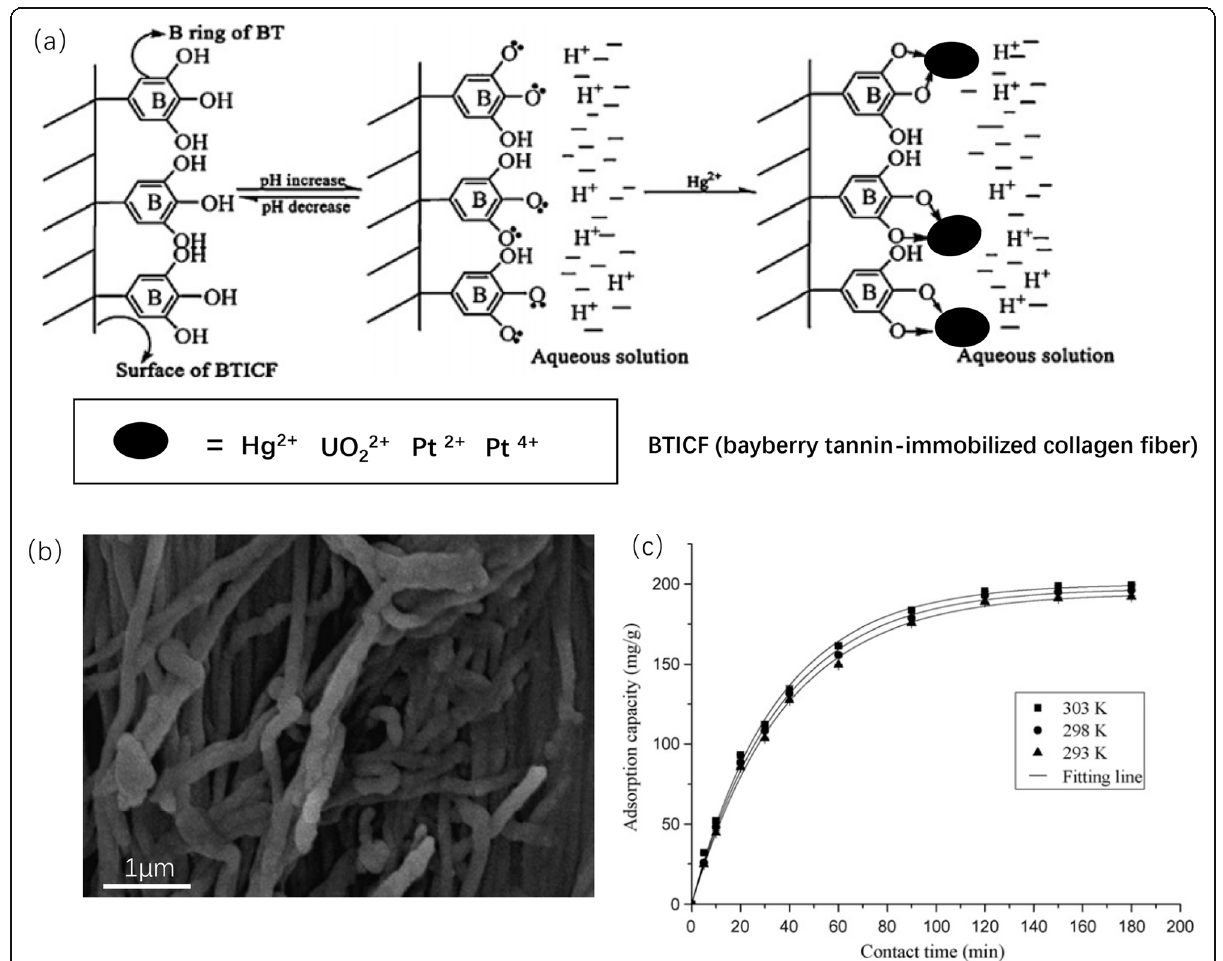
Fig. 3 a Mechanism of bayberry tannin-immobilized collagen fiber (BTICF) to metal ions; b SEM images of BTICF; c absorption capacity of modified skin collagen fiber to Hg2+ ions [43, 50]. Copyright (2009), with permission from Elsevier, and Copyright (2004), with permission from